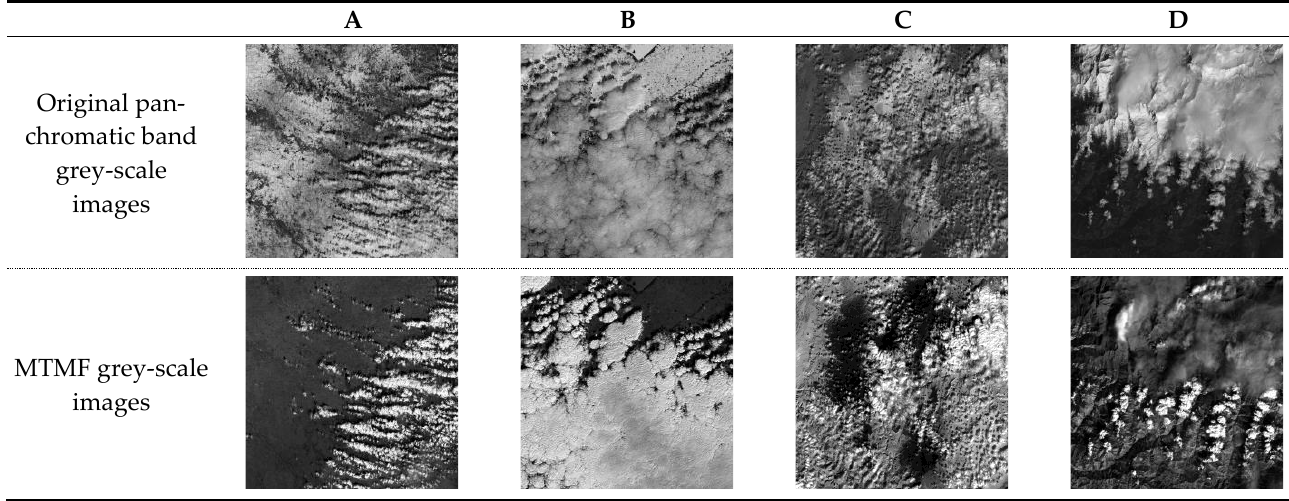
Figure 4. Grey-scale comparison images ( A – D ) of the original panchromatic band grey-scale images and the MTMF processed images.